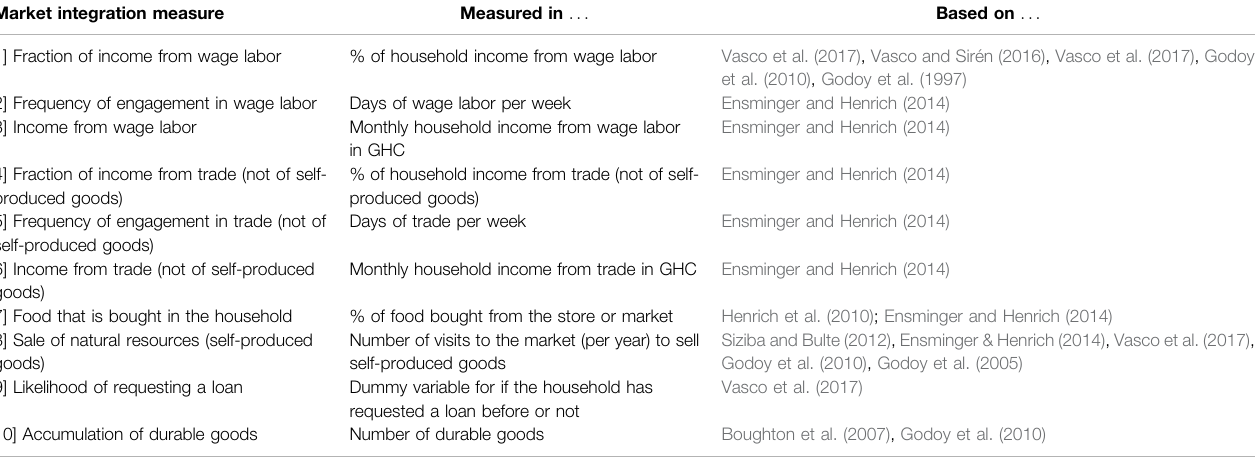
TABLE 2 | Market integration measures Market integration measure Measured in ...